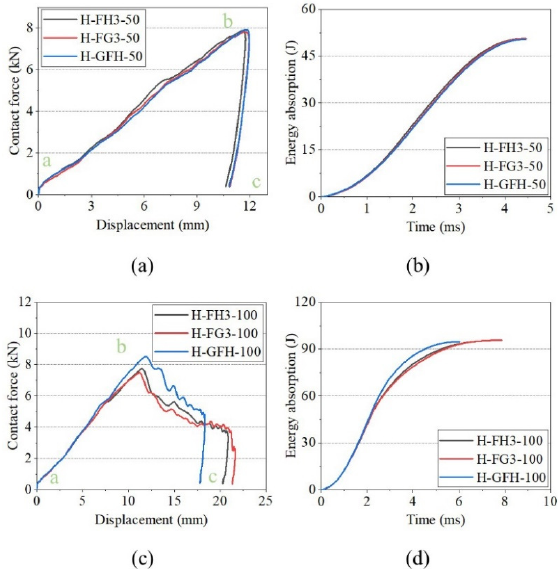
Figure 12. Impact responses of FH3, FG3, and GFH with hemisphere impactor. ( a ) Contact force– displacement curves of 50 J. ( b ) Energy-absorption curves of 50 J. ( c ) Contact force–displacement curves of 100 J. ( d ) Energy-absorption curves of 100 J.